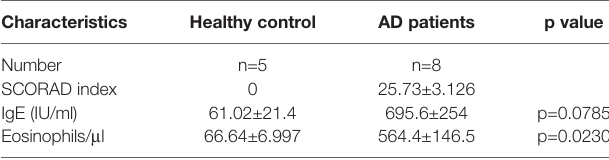
TABLE 1 | Values are presented as mean ±